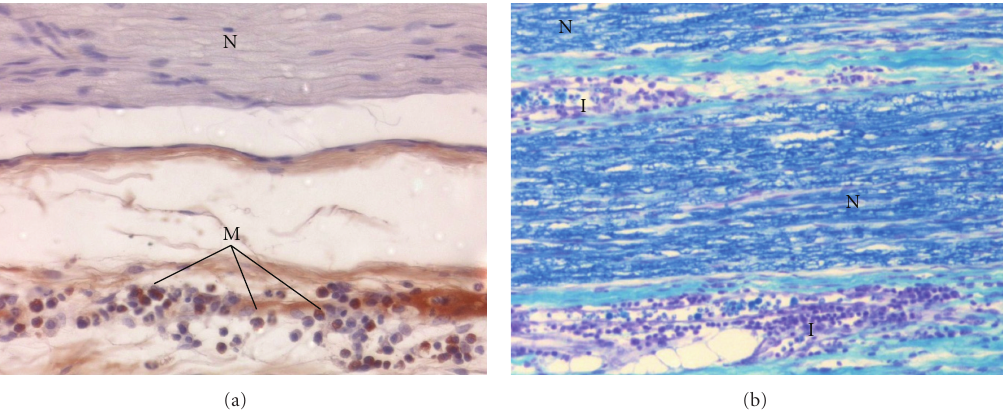
Figure 4: (a) Longitudinal microscopic view ( × 400, CD68 labeled [10]) of the median nerve after needle placement by means of nerve stimulation. N, nerve fascicle; M, brown, macrophages. Score value, 2.0. A minimal threshold current of 0.2 mA was applied for needle positioning. The needle contacted the nerve tissue. (b) Longitudinal microscopic view ( × 200, Kluver-Barrera [11, 12]) of the musculocutaneous nerve after needle placement by means of nerve stimulation. A minimal threshold current of 0.2 mA was applied for needle positioning. The needle contacted the nerve tissue. I, inflammatory cells; N, dark blue, myelinated vital nerve tissue. Score value,